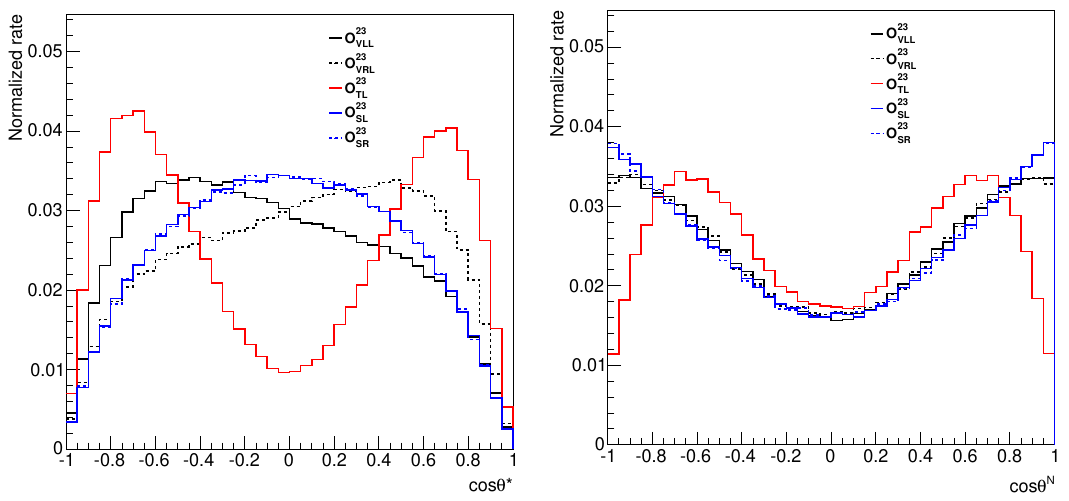
Figure 8 . Normalized differential cross sections, dσ/d cos θ ∗ and dσ/d cos θ N , for individual EFT coefficients (set equal to 1). The angles, θ ∗ and ψ , are related through θ ∗ = π − ψ . Both plots are made using the partonic MC events of pp → τνb process generated by MadGraph5 . Events in both plots are required to satisfy p T ( τ ) > 80 GeV, p miss